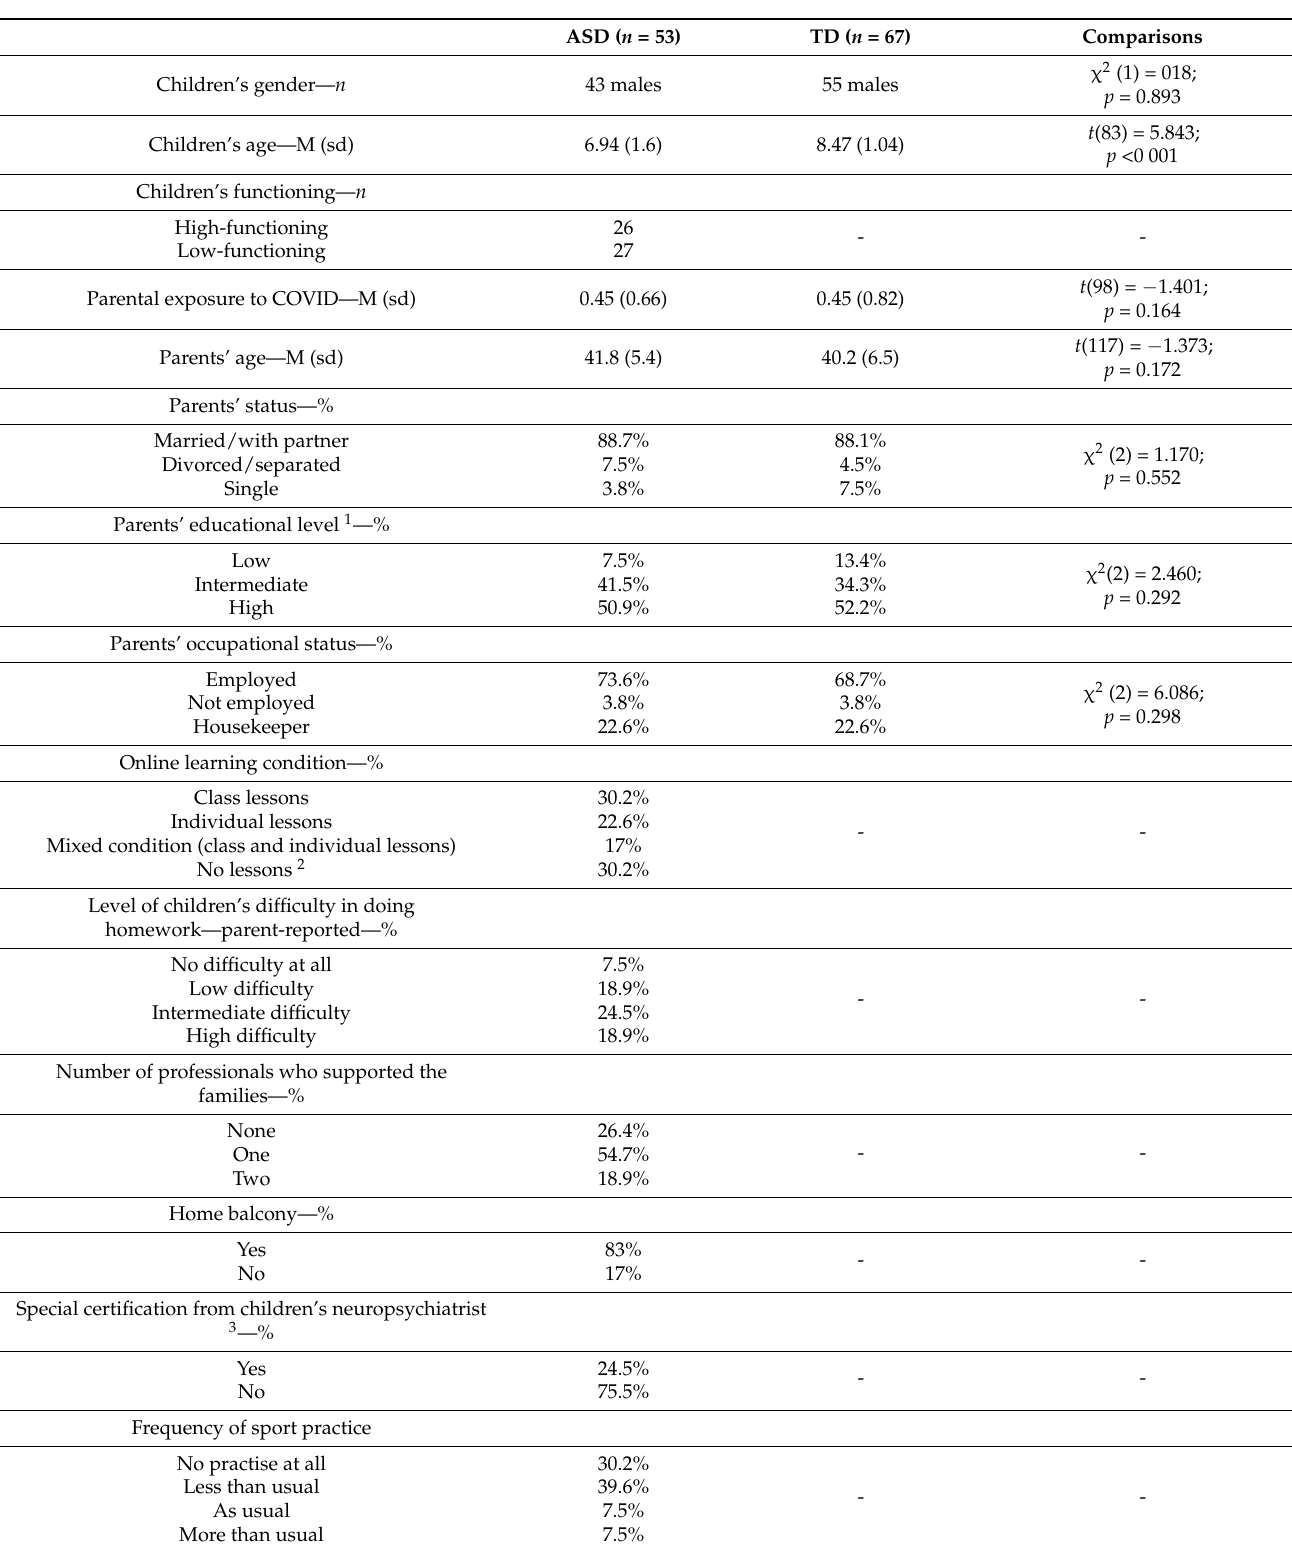
Table 1. Description of the socio-demographic variables of the ASD and TD samples, and results of the comparisons.